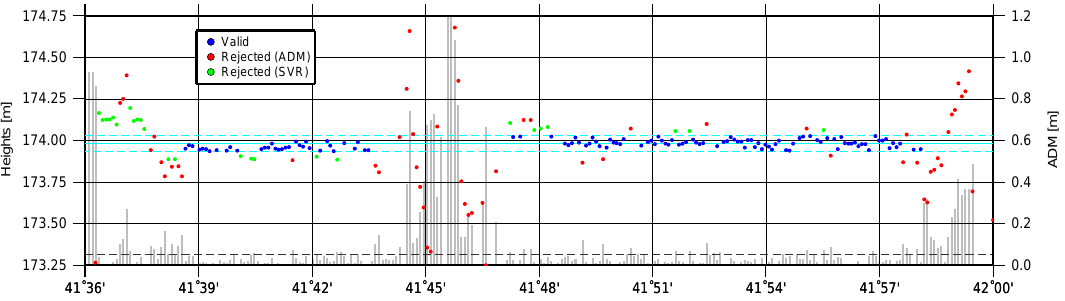
Figure 2. Example of an outlier detection using error threshold and SVR along a single satellite track over Lake Erie, which contains an island (between approx. 41 ◦ 44 (cid:48) and 41 ◦ 47 (cid:48) ). The result of the regression shows valid (blue) and rejected (red, green) water heights. The height errors based on ADM are plotted as grey bars. Thresholds for height errors and SVR are marked by dashed lines (black and cyan